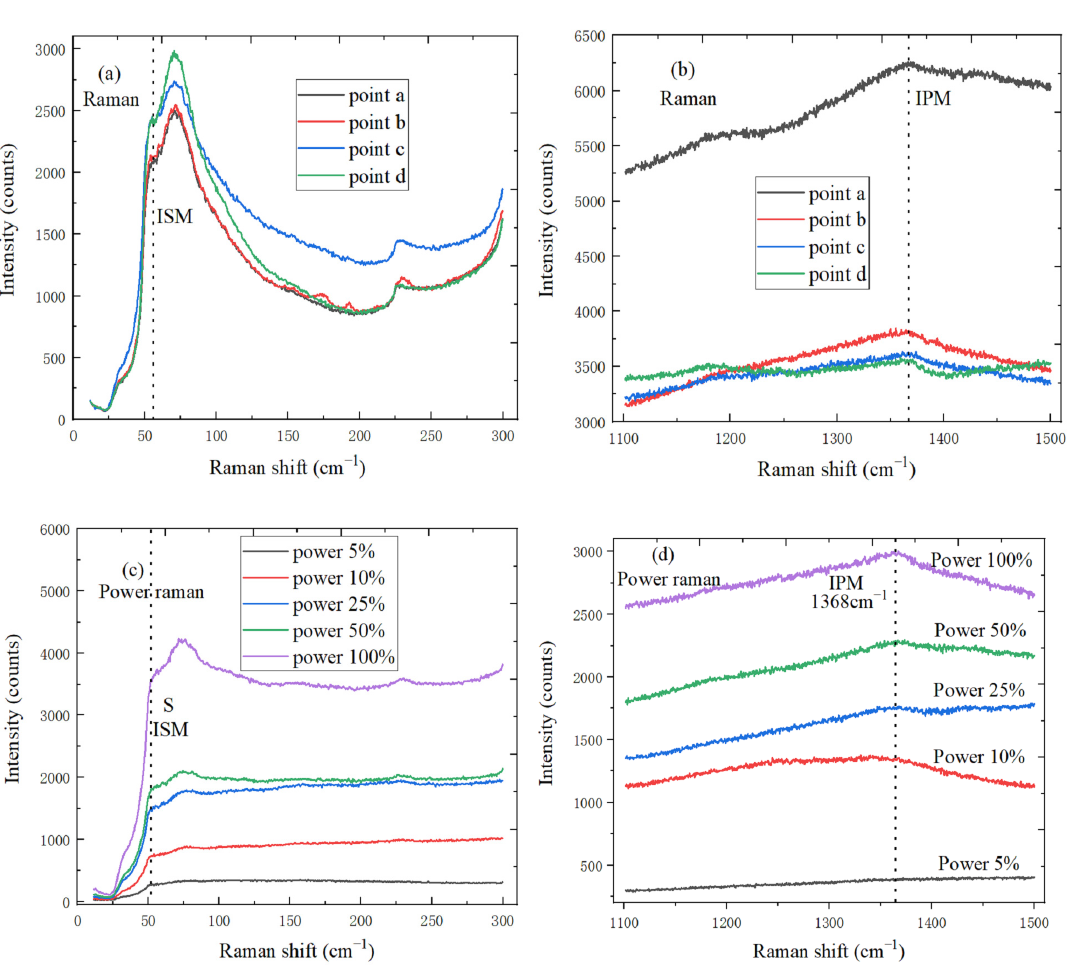
Figure 4. ( a ) ISM mode characteristic peaks of h-BN at different test points; ( b ) IPM mode characteristic peaks of h-BN at different test points; ( c ) ISM mode characteristic peaks of h-BN under the different laser power; ( d ) IPM mode characteristic peaks of h-BN under the different laser power.